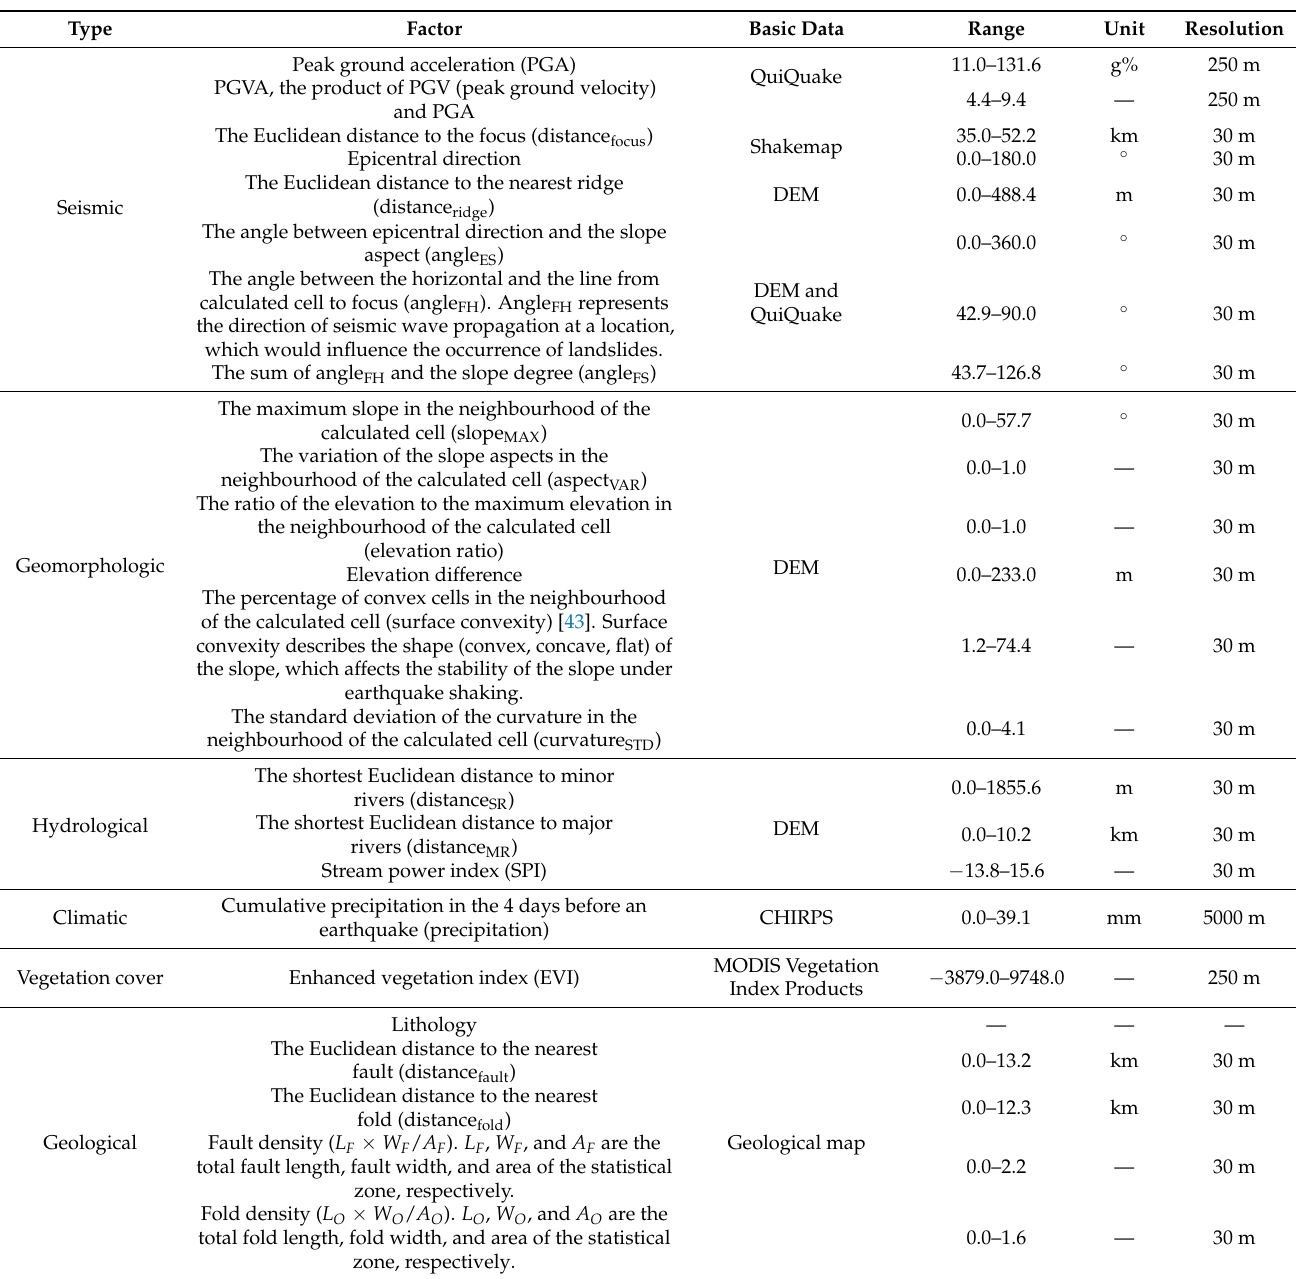
Table 2. Description of factors influencing